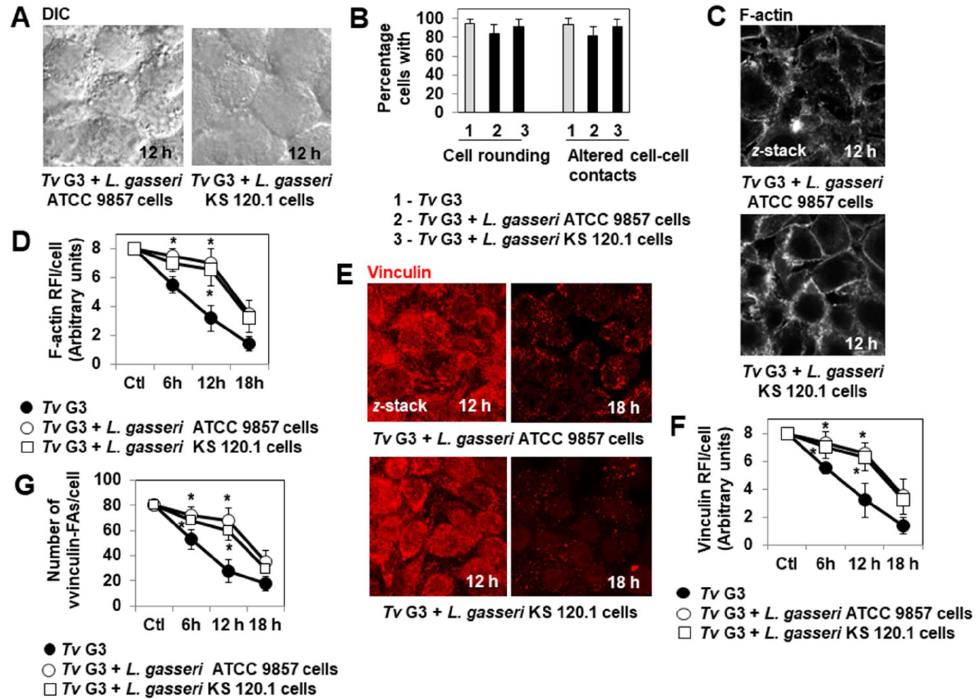
Figure 3. The prior adhesion of L. gasseri bacterial cells delays Tv G3-induced alterations to the F-actin network, cell-to-cell contacts, and focal adhesion contacts. In ( A ), representative differential interference contrast micrographs of T. vaginalis -exposed cells precolonized with L. gasseri ATCC 9857 or L. gasseri KS 120.1 cells. In ( B ), percentages of cells displaying rounding and alteration to cell-to-cell contacts (12 h post-infection). In ( C ), confocal laser scanning microscopy (CLSM) images of the F-actin network. In ( D ), decrease in F-actin relative immunofluorescence intensity (RFI) over time. In ( E ), representative CLSM micrographs of vinculin-positive FAs. In ( F ), decrease in vinculin RFI/cell over time. In ( G ), decrease in the number of vinculin-positive FAs/cell over time. The mi- crographs shown are representative of three independent experiments. Ctl: Control. Each value shown is the mean ± SD of three independent experiments. In ( D , F , G ), * p < 0.01 for comparisons with Tv G3.